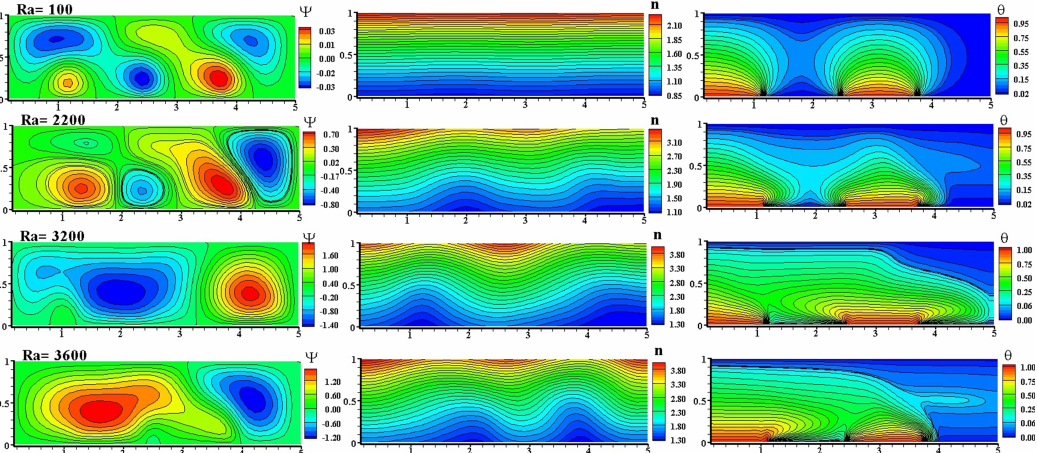
Figure 7. Case 5. From left to right, streamlines, microorganisms concentration and dimensionless temperature contours. For Sc = 1, Pe = 1, Ra T = 1708 and bioconvective Ra for 100, 2200, 3200 and 3600.